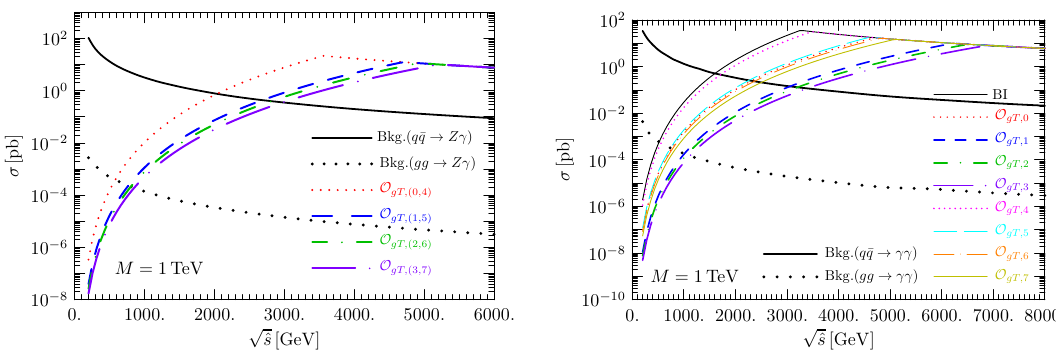
Figure 1 . The total cross sections for gg → Zγ (left) and gg → γγ (right) generated by the different dimension-8 gQGC operators at the parton level (colorful non-solid lines). For illustration, we assume that the scattering amplitudes have equal cut-off scales M = 1 TeV until their respective cross sections reach their unitarity limits, which we assume to be saturated at higher gluon-gluon √ centre-of-mass energies ˆ s . The cross sections for the SM background from q ¯ q annihilation are shown as solid black